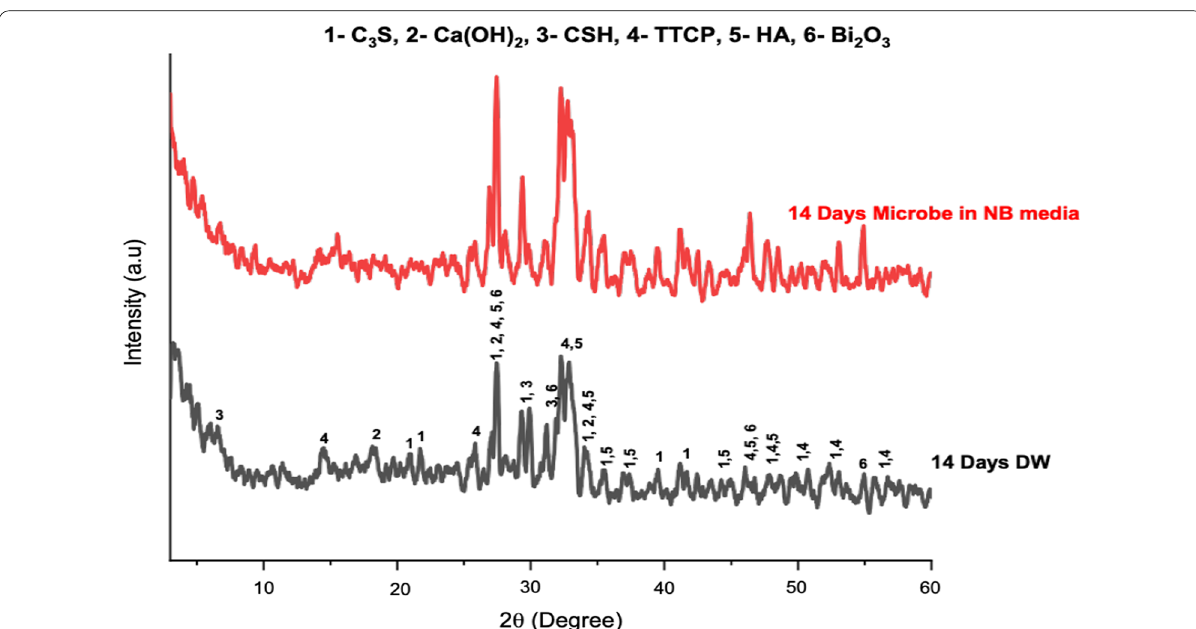
Fig. 8 X-ray diffraction patterns of 14-day sample cured in distilled water (DW) and Streptococcus thermophilus bacteria in nutrient broth NB